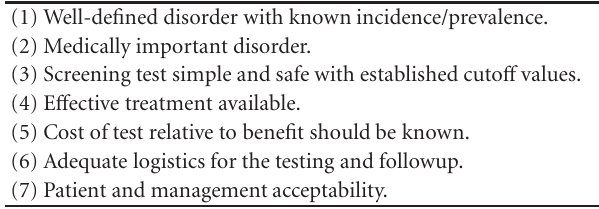
Table 1: Justification for screening test (adapted from Wald and Law 2010